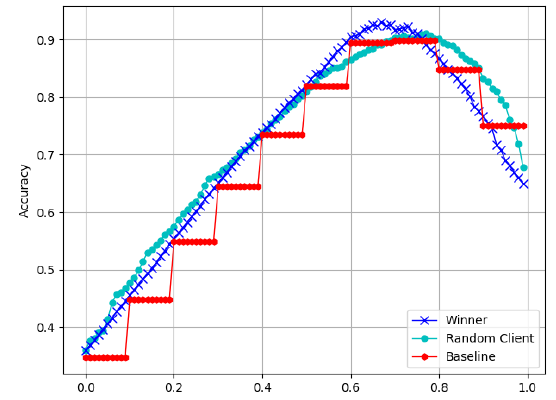
Figure 8. Accuracy for different participants.